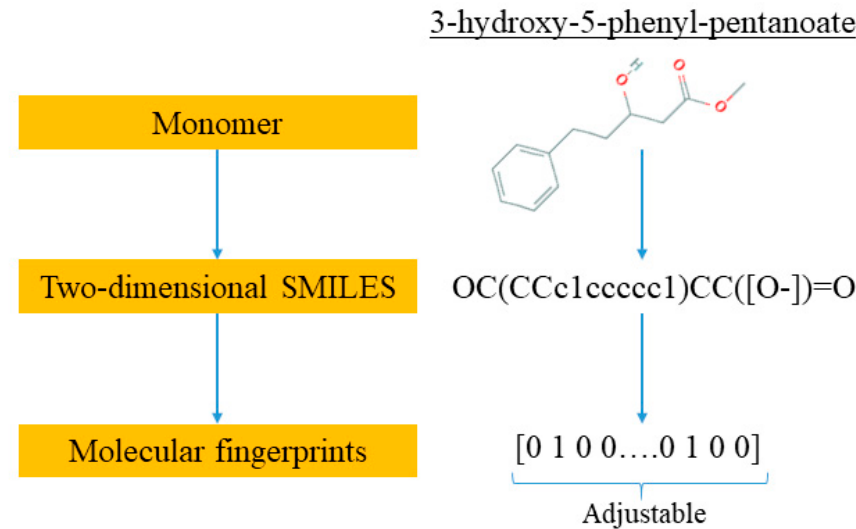
Figure 1. An example illustration of steps in encoding a chemical with digital representation to generate a molecular fingerprint.